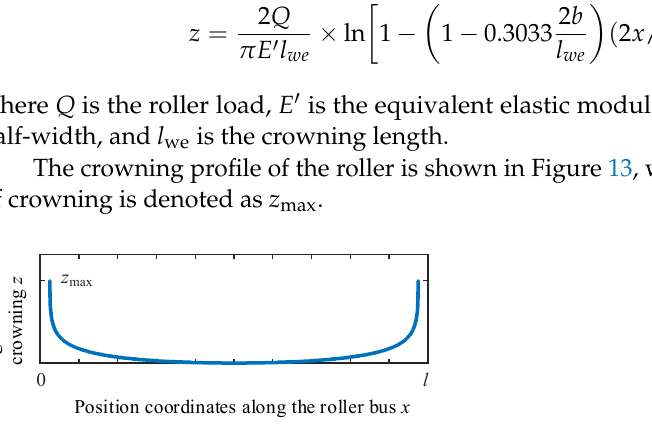
Figure 13. Logarithmic crowning profile of roller.